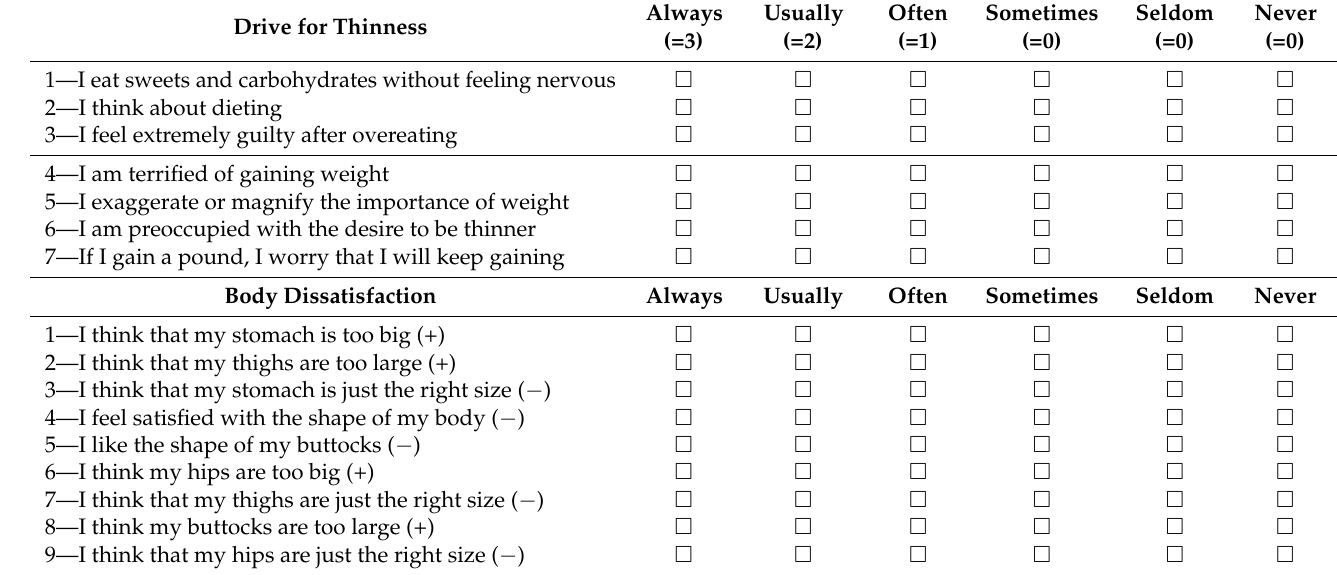
Table 1. Drive for Thinness and Body Dissatisfaction subscales of Eating Disorder Inventory-2. Drive for